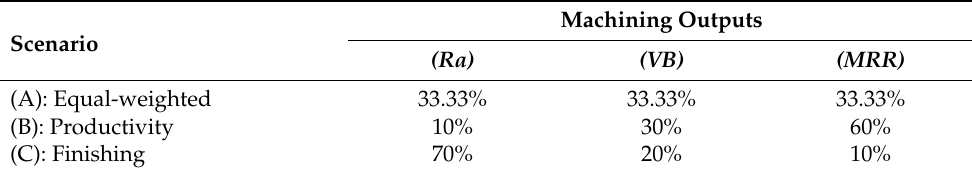
Table 5. The weighting factors for the machining scenarios.